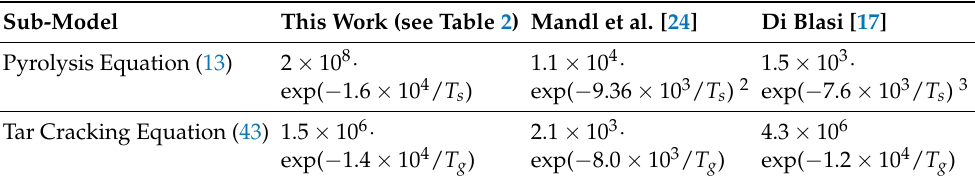
Table 4. Kinetic rates expressions used in the modelling; the rates in